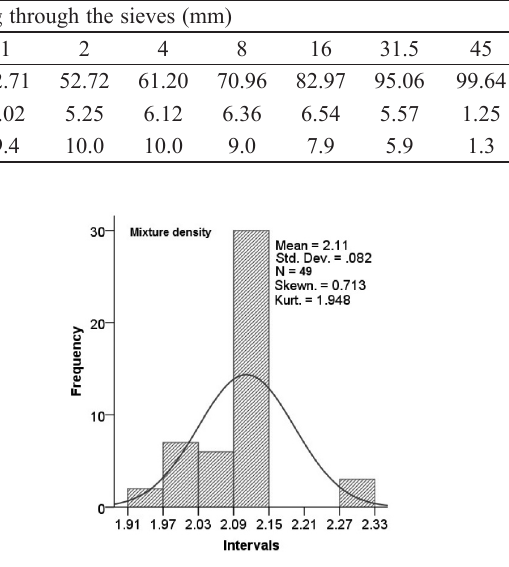
Fig. 8. Histograms of ASB mixture density theoretical curve of normal distribution and statistical indicators